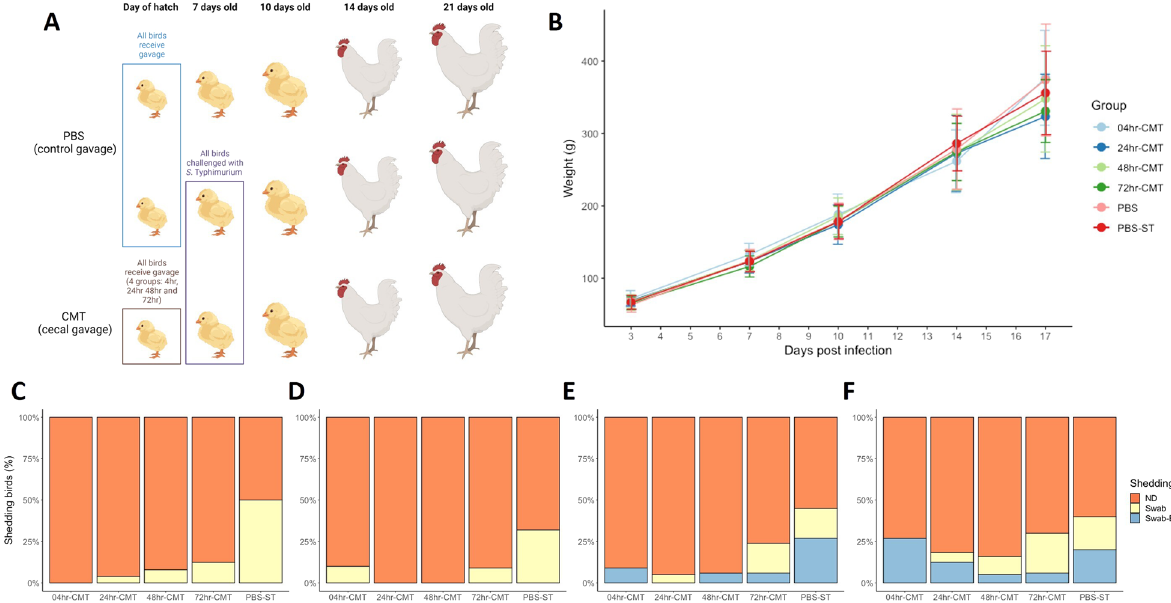
Fig. 1 Timing effect study design, bird weights and ST4/74 shedding results. A schematic of the transplant study showing birds given oral gavage of PBS at day of hatch and oral gavage of CMT within 4, 24, 48 and 72 h of hatch. Time points show procedures carried out on groups; at 7 days old ST4/74 was given to one PBS group and all CMT groups with 10 birds from each group killed for post-mortem analysis and collection of cecal content for 16S rRNA analysis. At 10, 14 and 21 days old a subset of birds from each group were killed for post-mortem analysis and sample collection. All birds in each group were swabbed at 3, 7, 10 and 14 dpi to assess faecal shedding of ST4/74. Schematic produced using BioRender. B All birds in each group were weighed at 3, 7, 10, 14, 17 and 21 days of age. There were no significant differences between groups on the average weight of birds. C – F Results of faecal shedding of ST4/74 at 3, 7, 10, and 14 dpi as measured by cloacal swabbing and plating on to ST4/74 selective agar. Shedding was recorded as no shedding (ND (Non-Detected), orange), ST4/74 detected following enrichment of swab (Swab-Enr, blue) and ST4/74 detected straight from swab onto plate (Swab, yellow). Compared to PBS treated groups, CMT treated groups were shown to have less faecal shedding of ST4/74 throughout the experimental